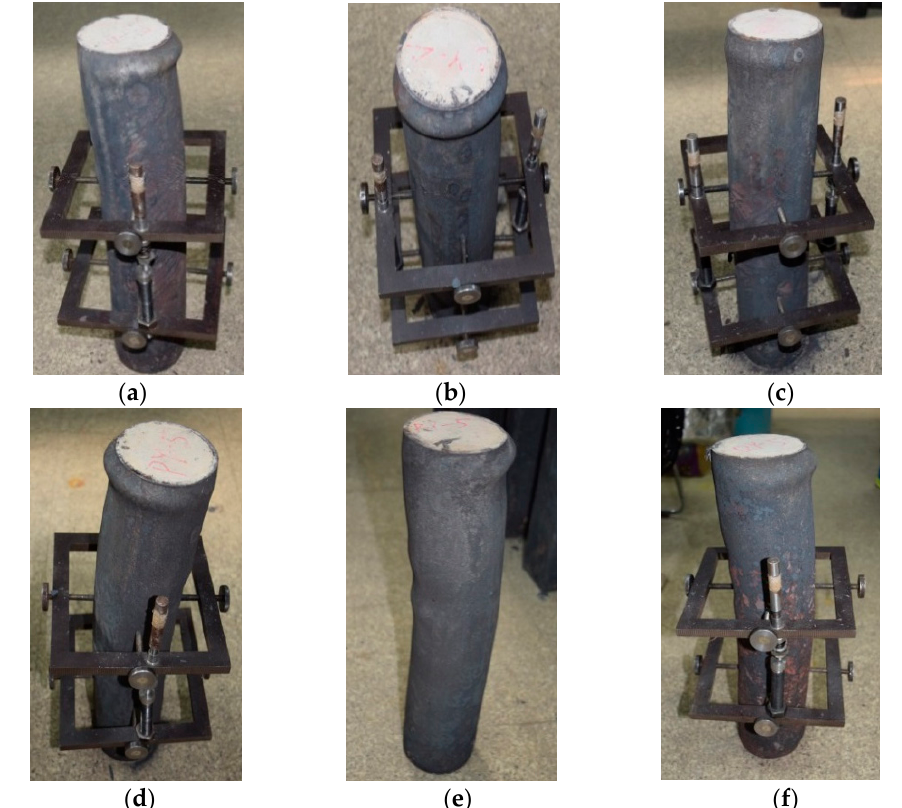
Figure 20. Failure modes of specimens: bending failure. ( a ) C-N-T1; ( b ) C-Ra-T1; ( c ) C-Rb-T1; ( d ) C-N-T2; ( e ) C-Ra-T2; ( f ) C-Rb-T2.